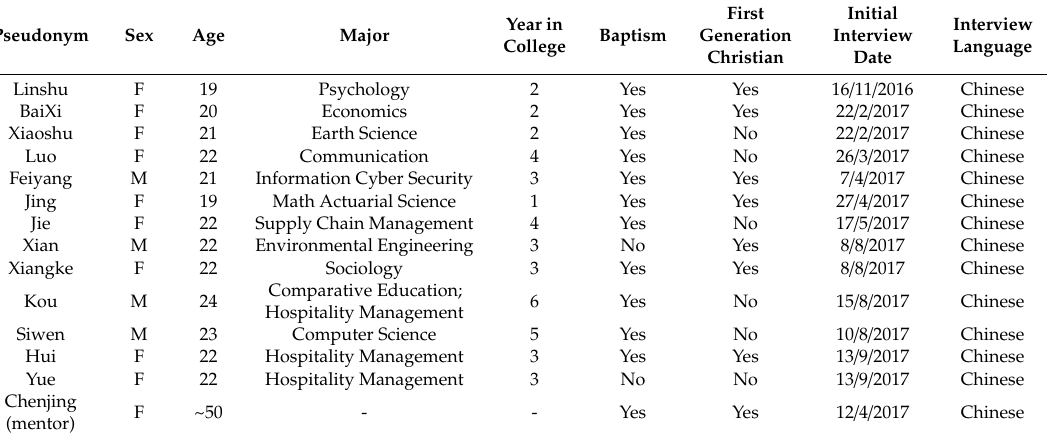
Table 1. Interview